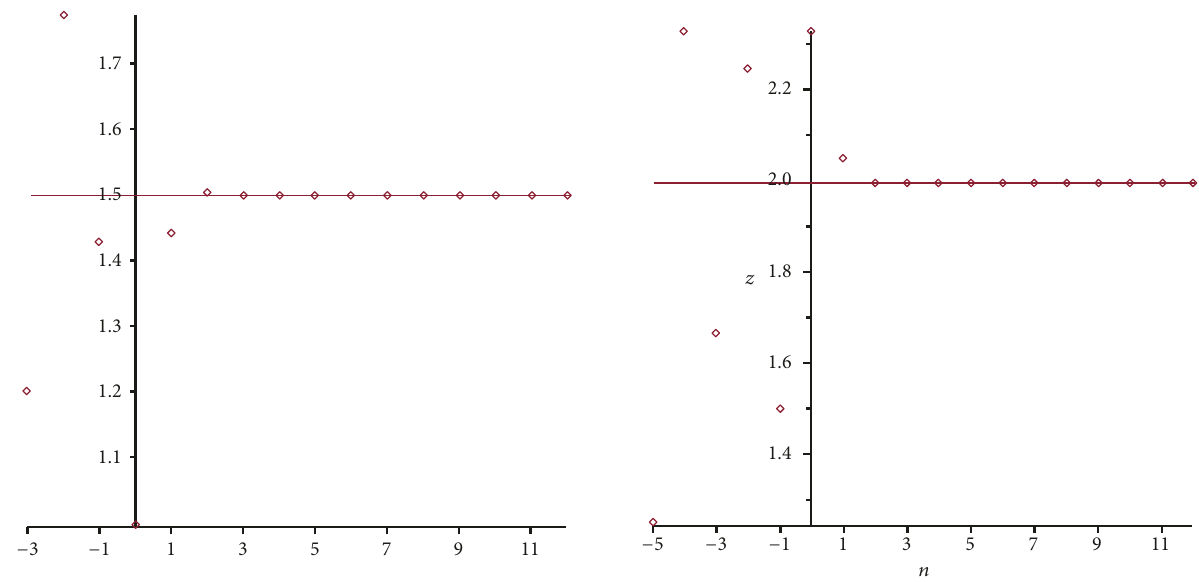
Figure 1: Profiles of {𝑧 𝑛 } ∞ 𝑛=−𝑘 with 𝑐 = 3/2, 𝑘 = 3 (left) and 𝑐 = 2, 𝑘 = 5